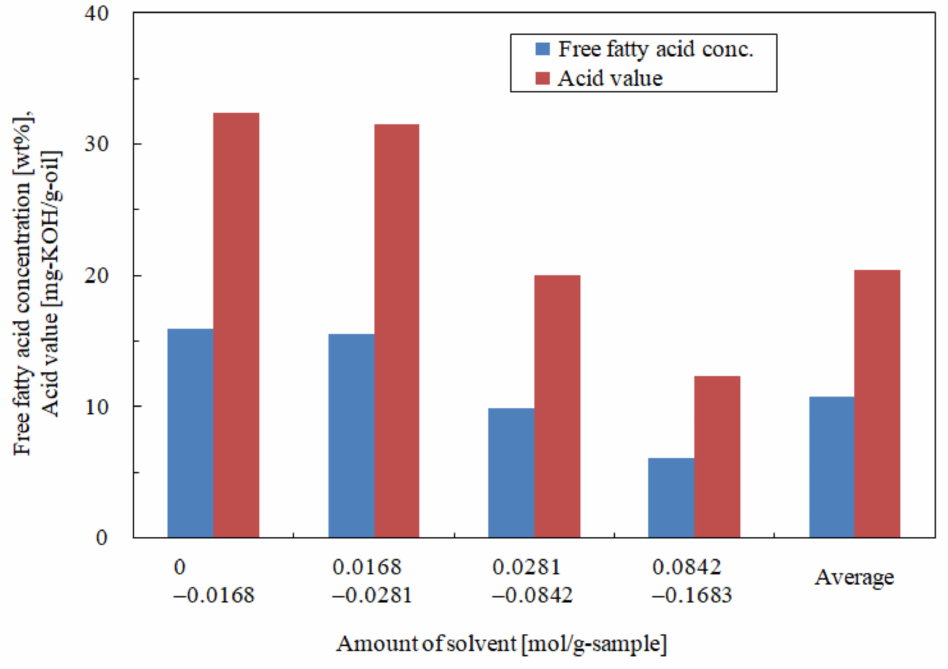
Figure 10. Influence of the amount of solvent (25 ◦ C, 5.1 MPa, and 0.88 CO 2 mole fraction) on the free fatty acid concentration and the acid value of the extracted